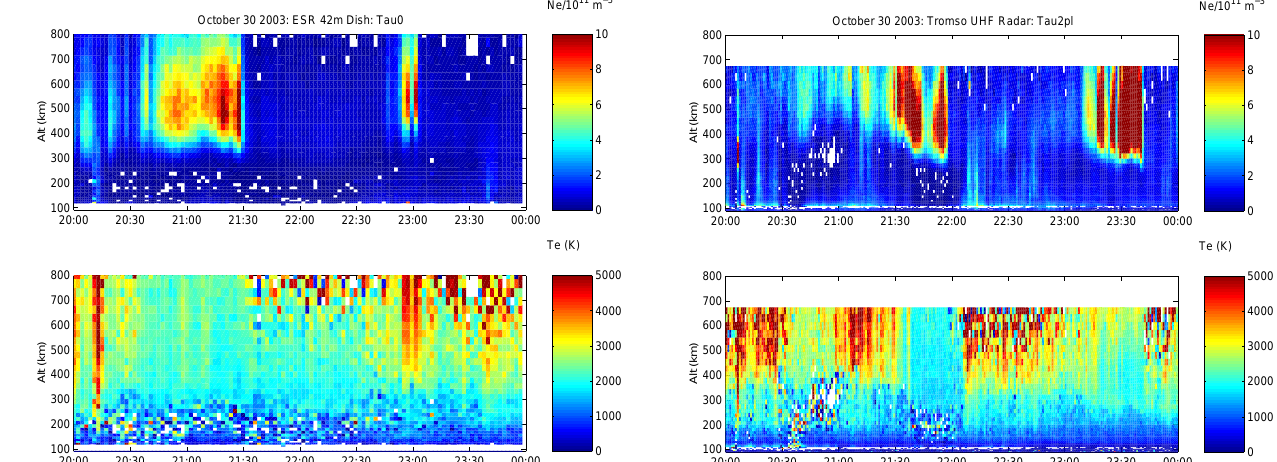
continent by solar photo-ionisation at 20:00 UT (local after- noon). The maximum TEC exceeded 120 TECu at 20:20